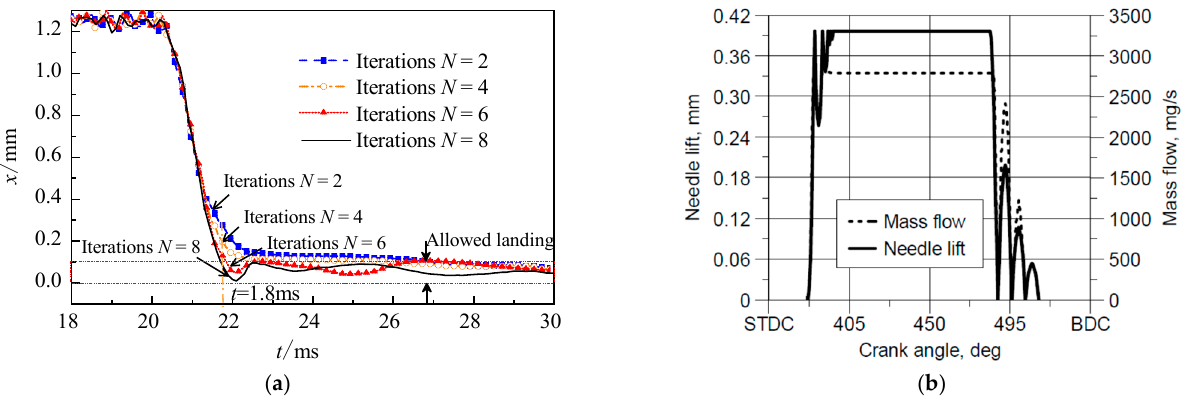
Figure 1. ( a ) Seating vibration of an injector driven with an MCELA (under the sensorless soft-landing control strategy). ( b ) Seating vibration of an injector driven with a solenoid [20].